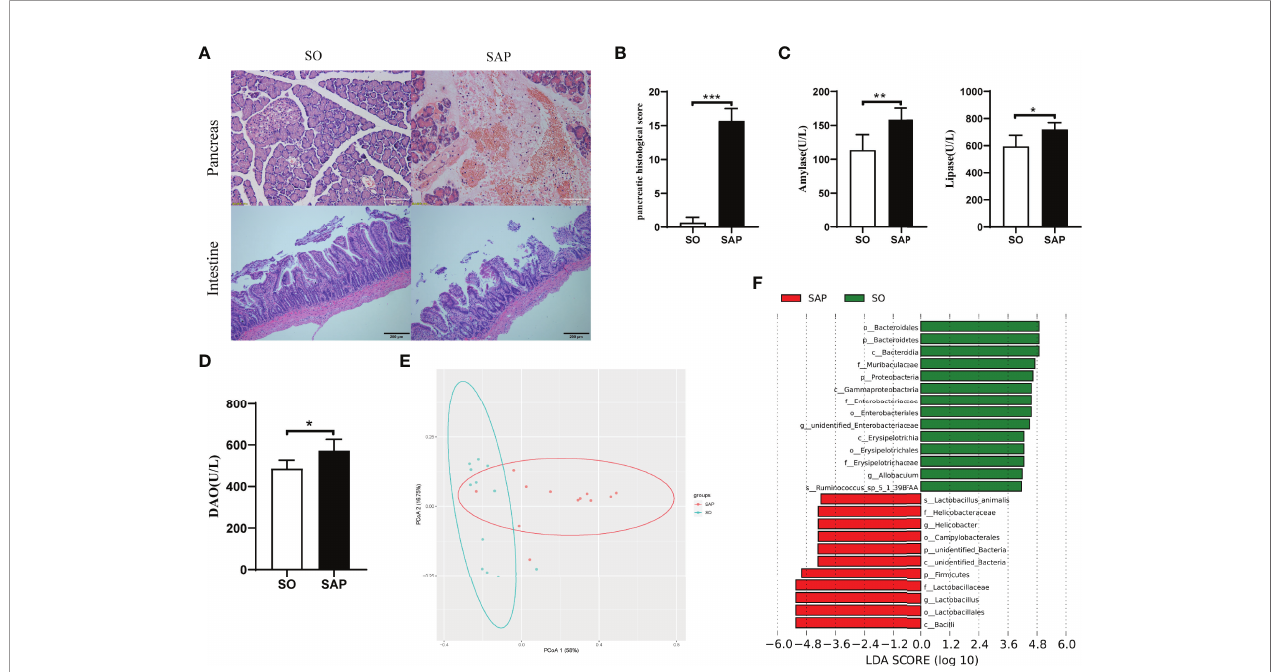
FIGURE 1 | Changes in histopathology, enzymology and gut microbiota structure in the SAP rat model. (A) Histopathological observation of the pancreas (HE, ×200) and intestine (HE, ×100) of SO and SAP rats; (B) Pancreatic histological score of SO and SAP rats; (C) Amylase and lipase levels in the serum of SO and SAP rats; (D) Diamine oxidase (DAO) levels in the serum of SO and SAP rats; (E) PCoA of the gut microbiota structure and abundance in SO and SAP rats; (F) Linear discriminant analysis (LDA) effect size of the SO and SAP groups. SO, sham operation group; SAP, severe acute pancreatitis group. Student ’ s t-test for Panels B – D (n = 6 in each group); * p < 0.5, ** p < 0.01, *** p <